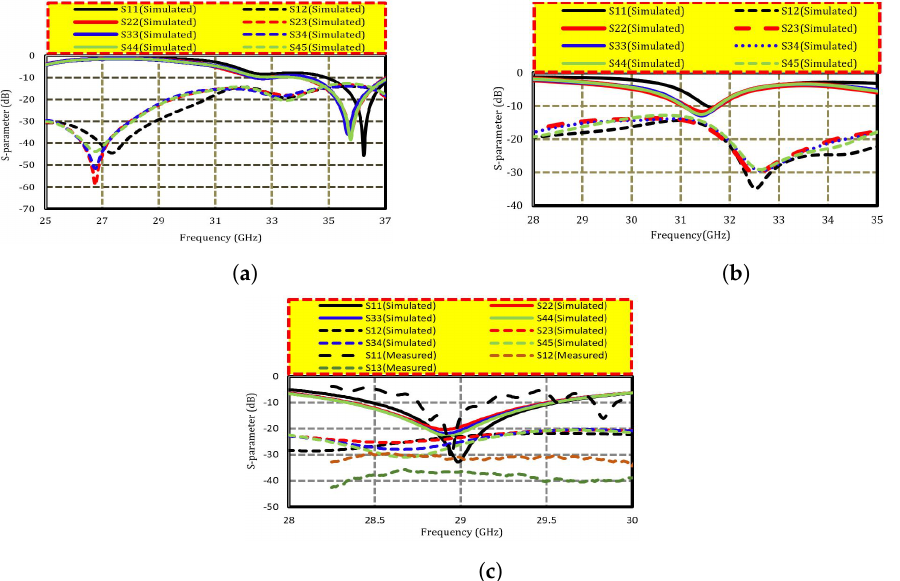
Figure 5. S-parameter of ( a ) straight elements, ( b ) bend elements, and ( c ) proposed eight-element MIMO